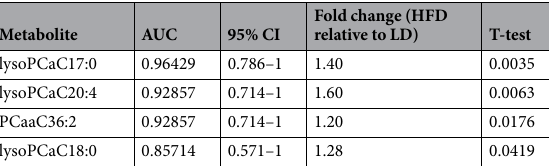
Table 1. ROC analysis of metabolites longitudinally upregulated in HFD-induced osteoarthritis. Table of selected metabolites identified from VIP ≥ 1 and significantly upregulated by One-way ANOVA (p < 0.05) at 18 weeks of diet and 9 months of age in HFD-fed mouse plasma vs LD-fed or baseline mouse plasma. AUC; area under curve, CI; confidence interval; HFD; high fat diet; LD; Lean diet. Significant P-values (p < 0.05) determined by Student’s t-test of log-transformed, auto-scaled data comparing animals with severe (OARSI score ≥ 3) vs. non-severe (OARSI score < 3) osteoarthritis.